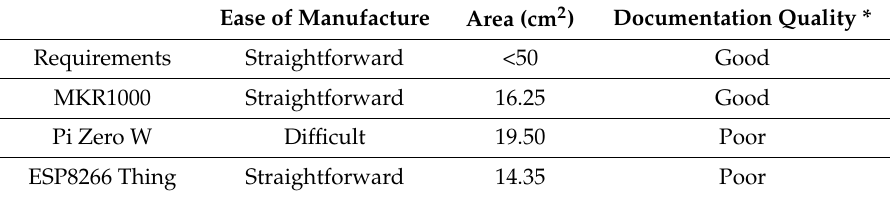
Table 3. Comparison of Wi-Fi microcontroller boards